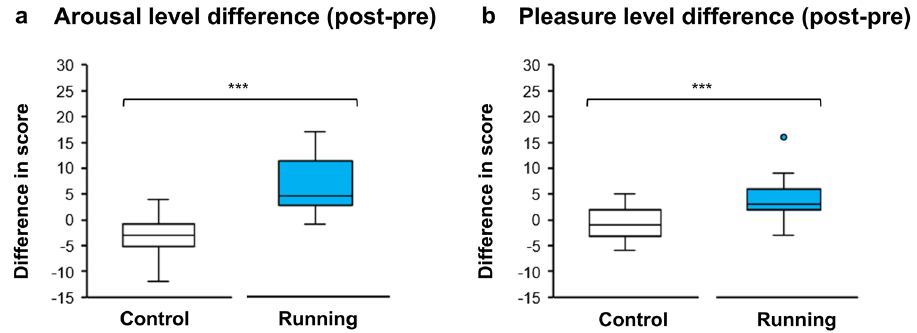
Figure 1. Comparison in mood change [(post-session)—(pre-session)] between control and running: ( a ) arousal level difference and ( b ) pleasure level difference. The bottom, middle and top lines of each box indicate the 25th, 50th (median) and 75th percentiles, respectively. Whiskers above and below each box refer to the most extreme point within 1.5 times the interquartile range. Points above the whiskers are outliers. *** = p < 0.001.